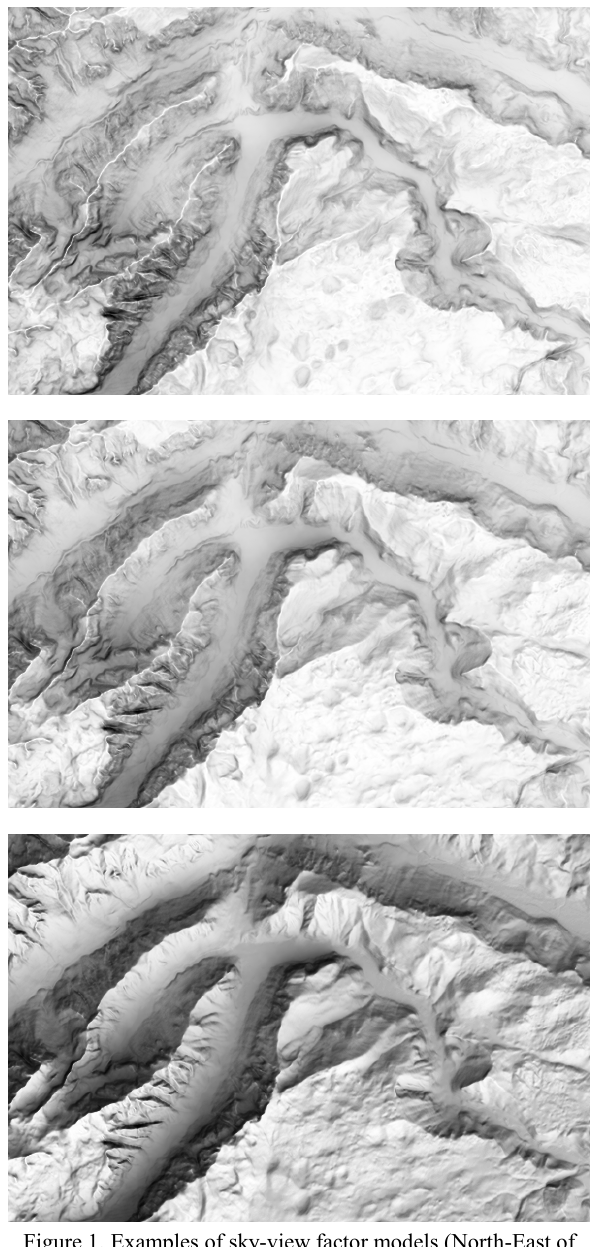
Figure 1. Examples of sky-view factor models (North-East of Slovenia, area of 15×10 km) with three different levels of anisotropy: isotropic (above), low anisotropic (middle), and high anisotropic (below); solar azimuth equals 135°and solar zenith angle